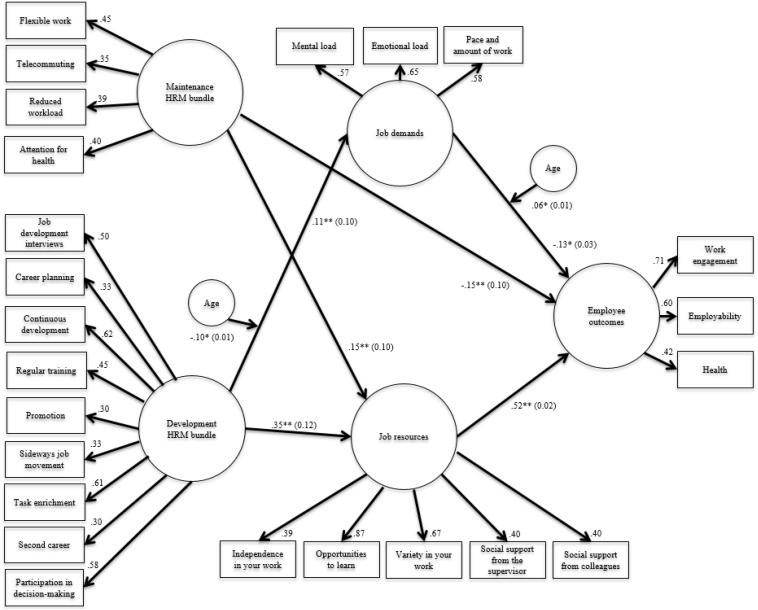
Mediation model of demands and resources in the relationships of HRM bundles and employee outcomes moderated by age. Values indicate standard loadings from the latent variables to the items (McNeish et al., 2018). In addition, we reported β coefficients and SE in brackets based on a SEM-model using manifest variables (see text).